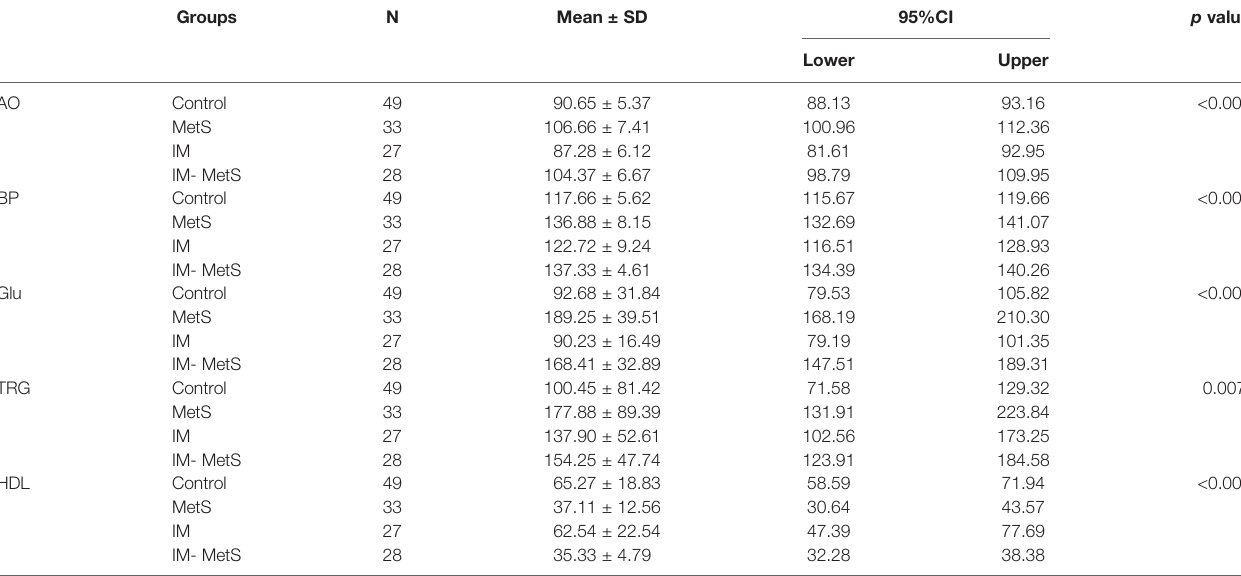
TABLE 2 | Comparison of MetS characteristics between the groups.